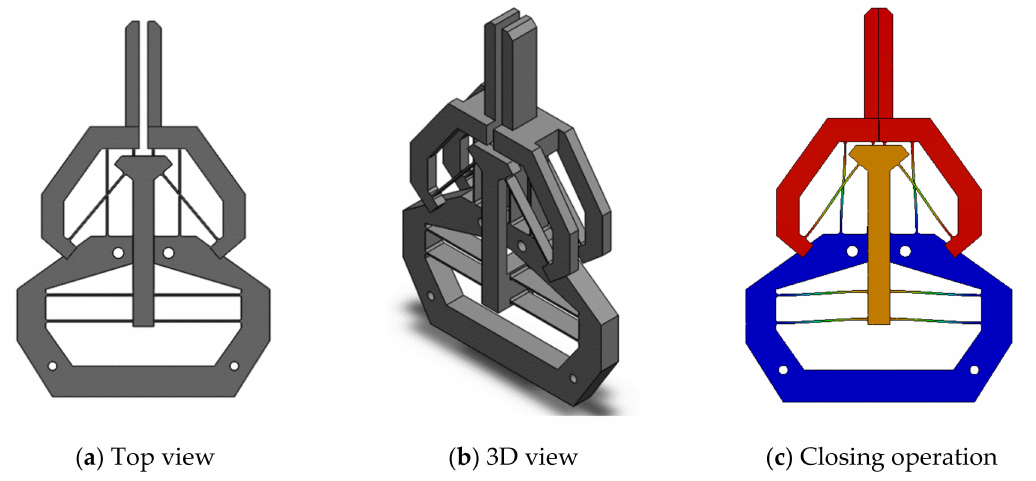
Figure 15. A symmetrical sandwich design for reducing footprint.